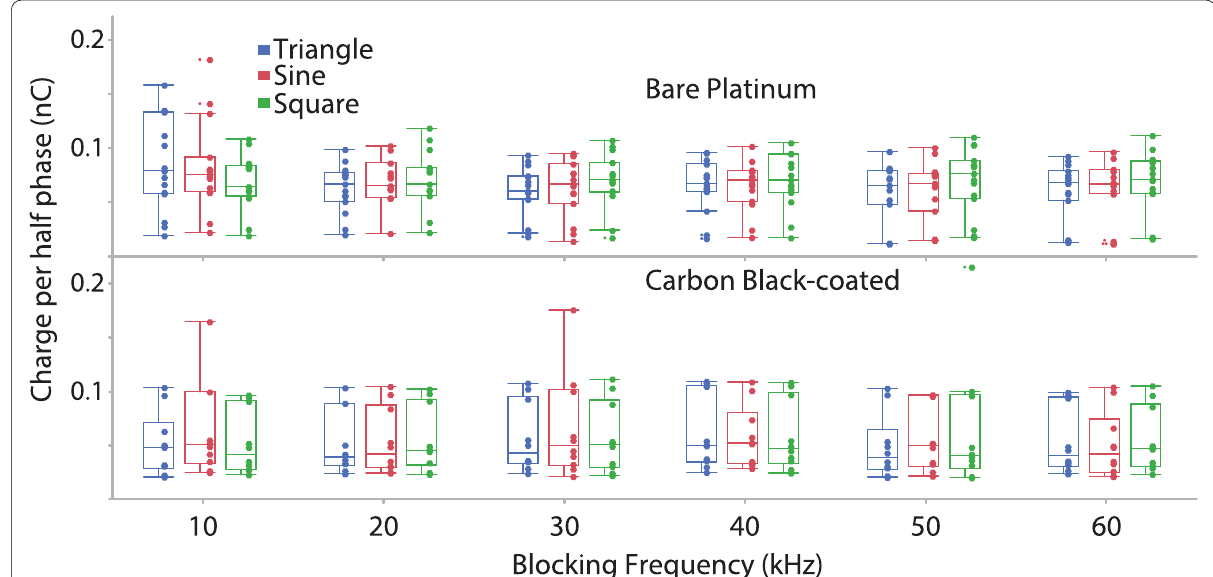
Fig. 11 Charge per half cycle at block threshold. There was an overall significant effect of blocking frequency ( P < 0.0001). This effect was due mainly to the 10 kHz data, and results are suggestive of the exponential trend that was predicted by the MRG model. The application of carbon black coating did not cause a significant reduction in charge required to maintain